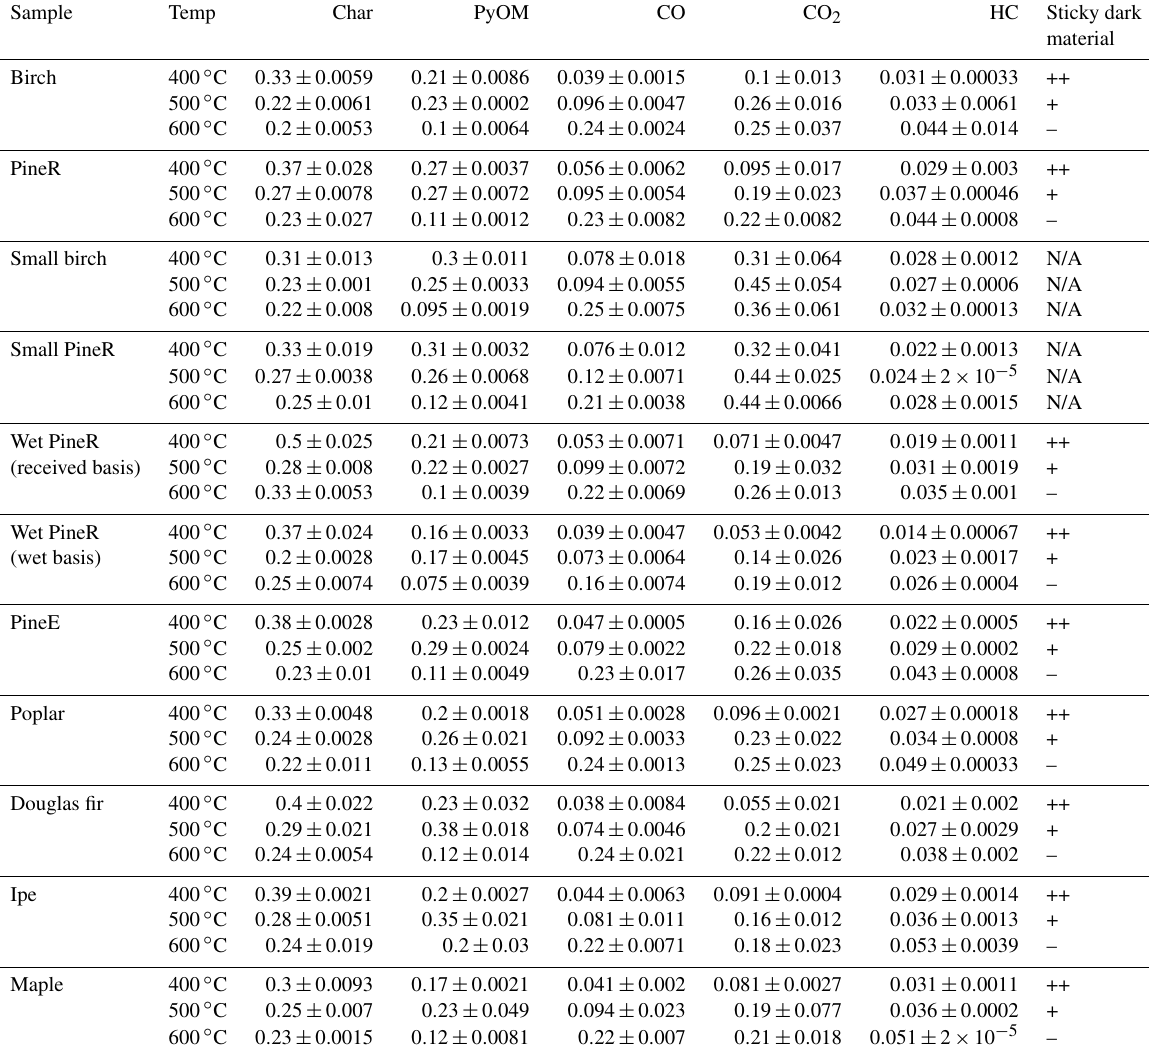
Table 1. Average yields of measured products for each replicated experimental condition. Wet pineR yields are expressed on a wet basis (the mass of the wood used included the moisture content) and on an as-received basis (the mass of the wood before increasing its moisture). The last column is a semi-quantitative indicator of whether the production of the dark sticky material was detected during the experiment. In the table “–” indicates the lack of production and “+” indicates production, with “++” signifying more production than +. “N/A” indicates that a detection was not possible during those